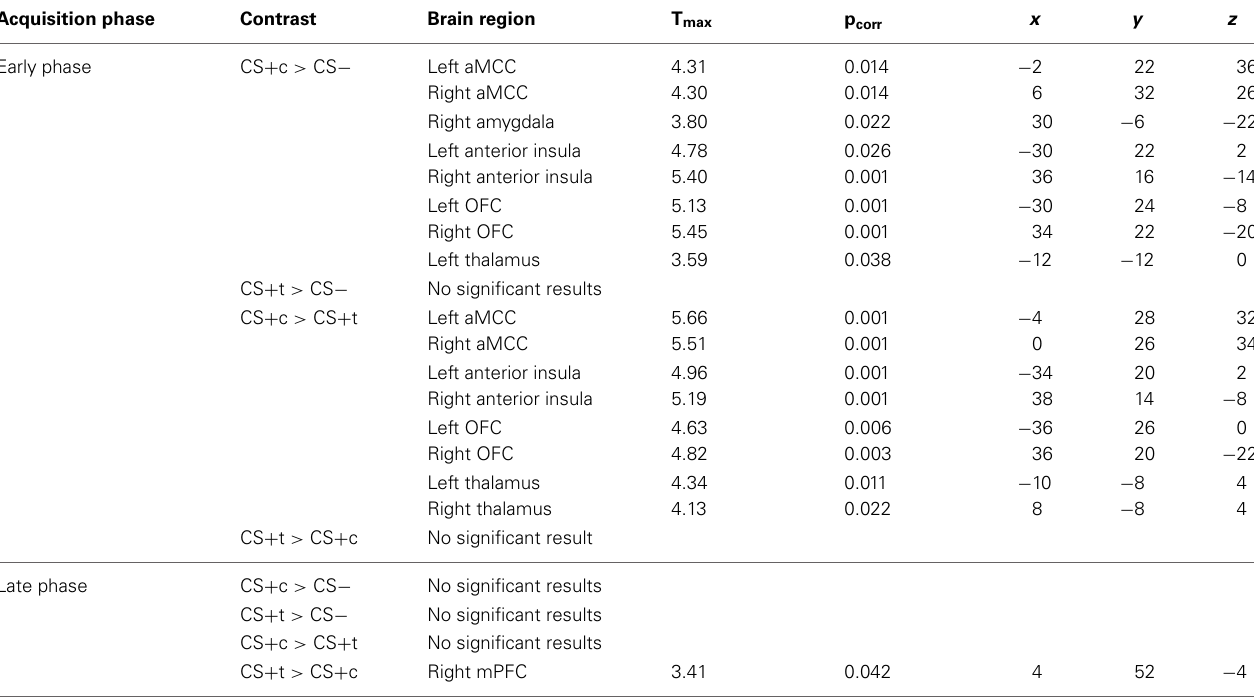
Table 1 | Results of the conditioned responses in early and late phases of the acquisition phase. Acquisition